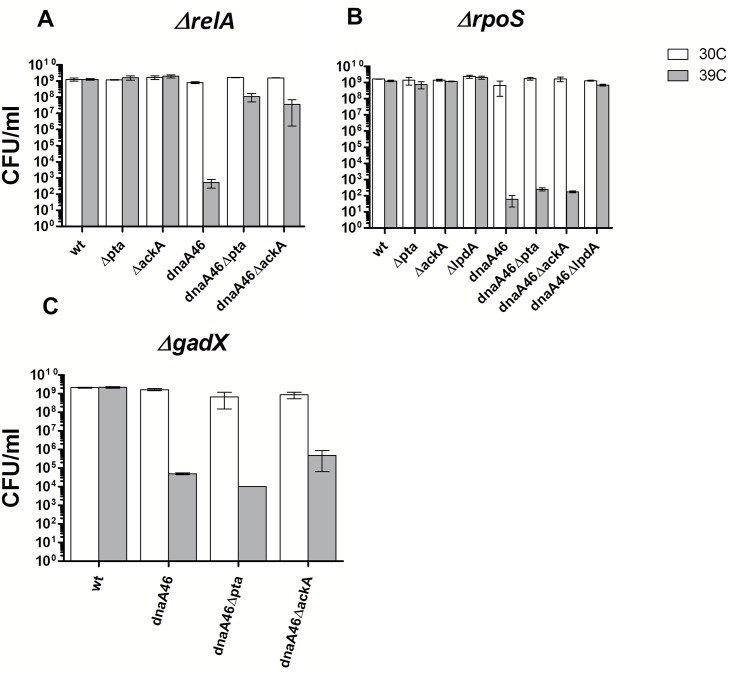
The influence of rpoS (A), relA (B) and gadX (C) on the suppression of the dnaA46 temperature-sensitive growth by mutations in the acetate overflow pathway or lpd genes.Bacteria were grown at 30°C in LB medium to early exponential phase, subsequently serial dilutions were prepared and plated on LB plates at 30 and 39°C. Growth was estimated by CFU. Data represents mean ± SEM of three independent experiments.